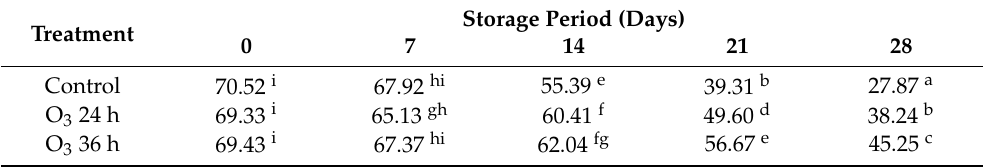
Table 3. Effect of gaseous ozone (0.25 mg/L) on L* values of on mango fruit inoculated with L. theobromae , stored at 10 ◦ C for three weeks and ripened at ambient temperature for one week. Treatment